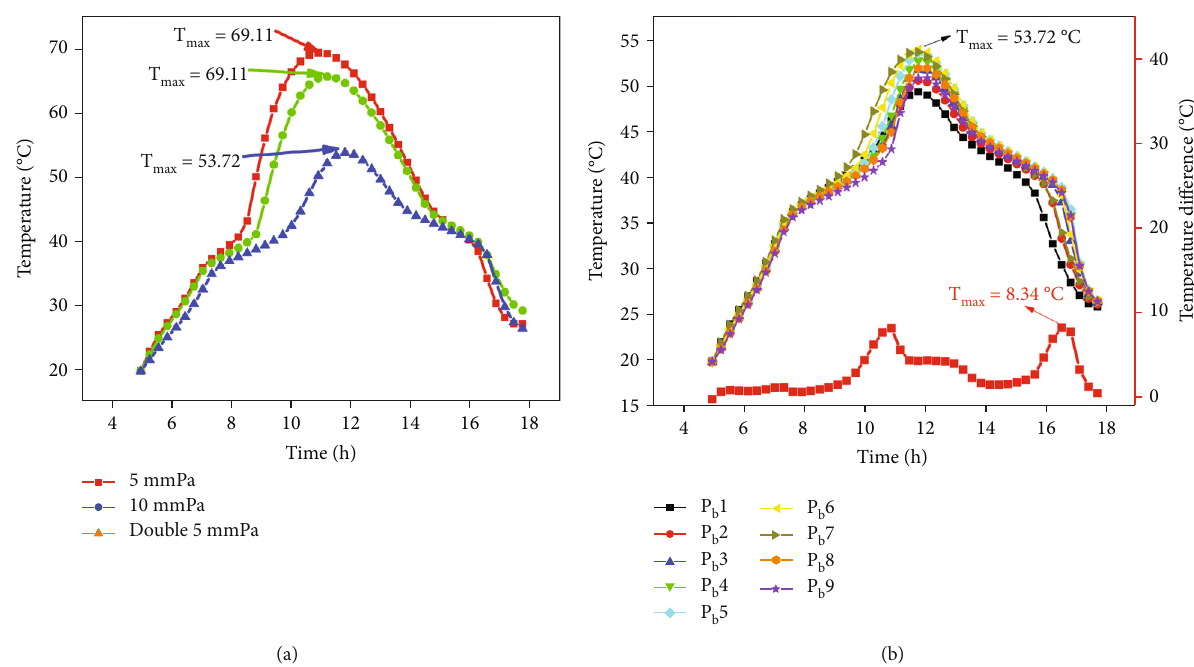
Figure 14: Analysis of heat generation behaviors: (a) temperature variations of batteries in three types of HP – PBIS and (b) temperature variations and temperature di ff erence of battery in HP – PBISc.